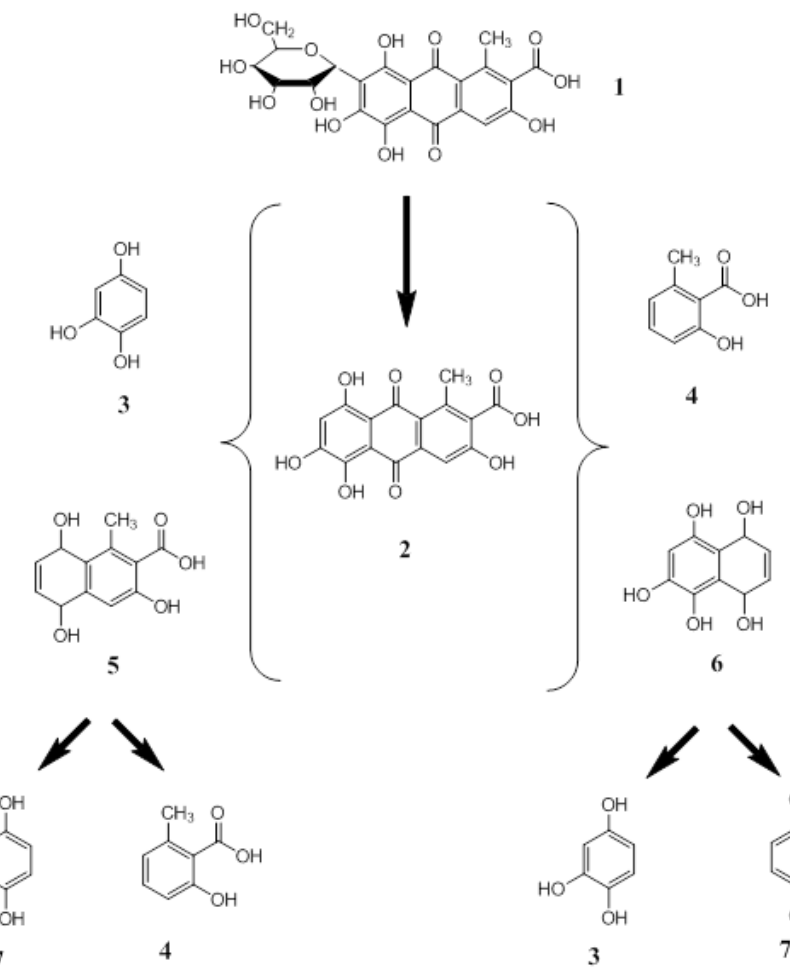
FIGURE 5. Main metabolites proposed for the degradation of the carminic acid structure, which is present in the cochineal extract effluent, using the Tv fungus (based on Cajthaml’s proposal et al.[28]). 1 = Carminic acid; 2 = 1-carboxy 2- methyl 4,6,7,10-tetrahydroxy anthracene-3-8-dione; 3 = 3-4-dihydroxy phenol; 4 = 2-hydroxy 6-methyl benzoic acid; 5 = 1-methyl 3,5,8-trihydroxy 2-naphthalic acid; 6 = 1,2,3,4,5,6-penthahydroxy naphthalene; and 7=